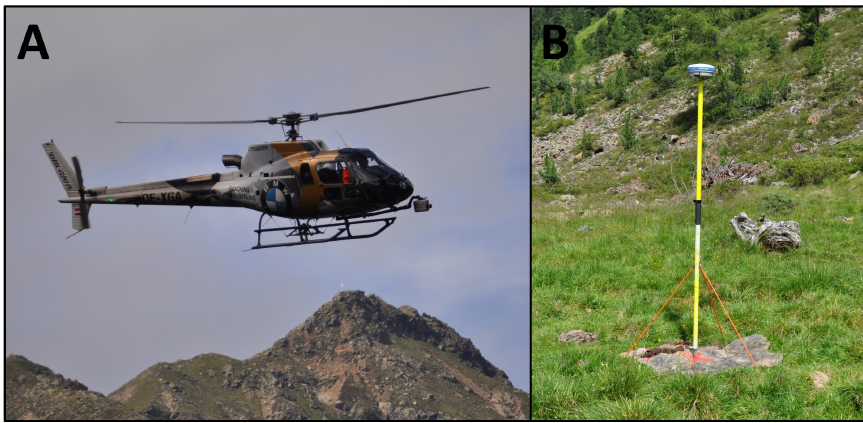
Figure 4. LiDAR data acquisition in Horlachtal. A: VP1-HeliCopterPod mounted on an Airbus Helicopters H125 Ecureuil. B: One of two dGNSS base stations on the ground.